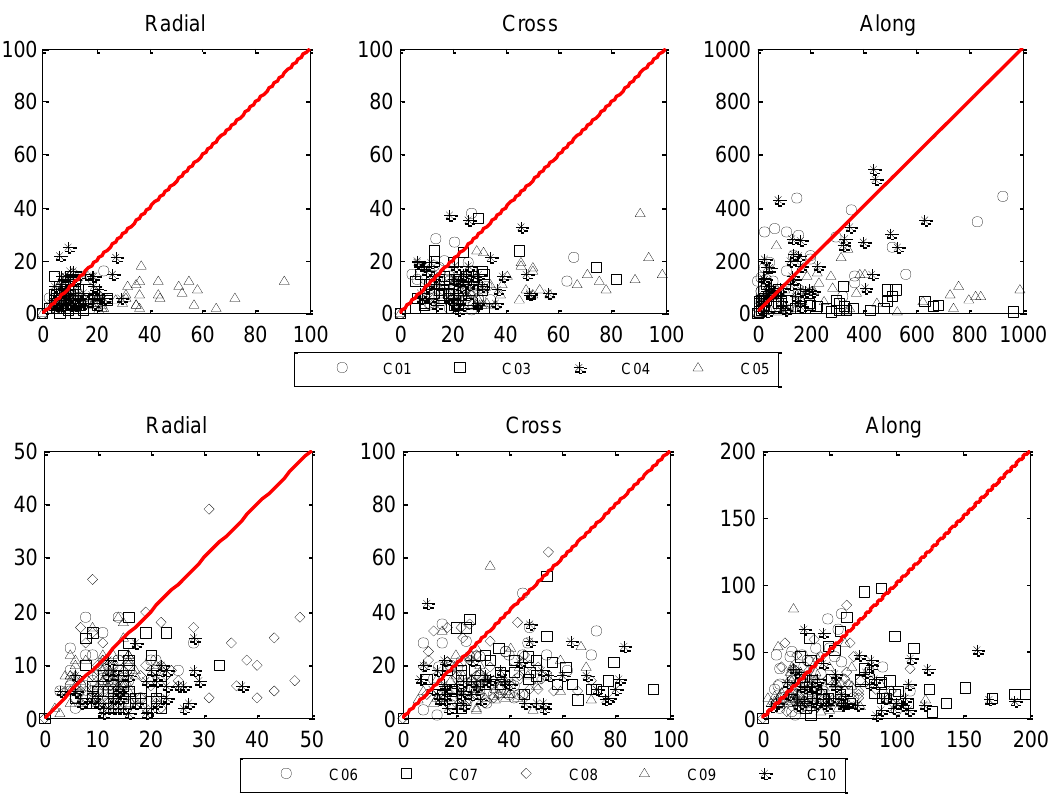
Figure 9. Relationship of the orbit RMS from the Chinese regional network (CHN) and the global networks (ALL). x-axis denotes the RMS of CHN, while y-axis represents orbit RMS of ALL. The red line with slope rate 1.0 divides each figure into two parts, of which the right down stands for the